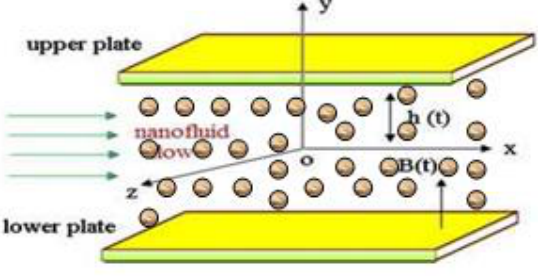
Fig. 1. Model diagram of the flow